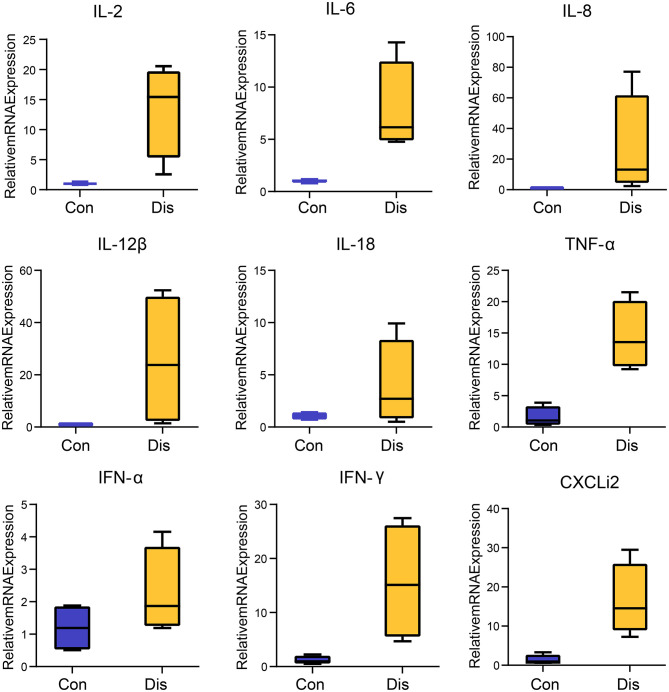
Box–whisker plots of the cytokines expression in the chicken's bursa of Fabricius. Each value indicates the mean ± SEM, n = 4.